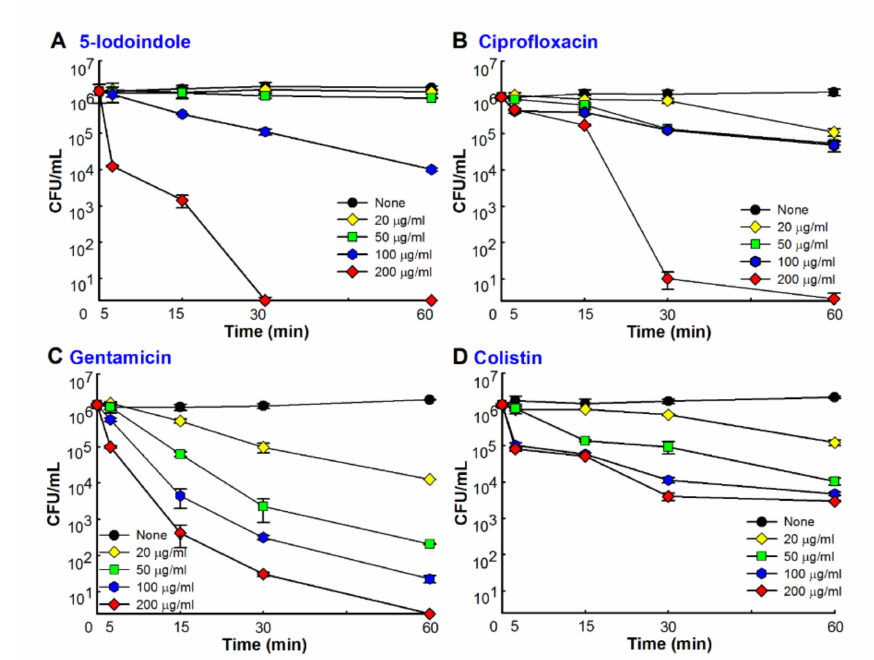
Figure 4. Rapid killing of A. baumannii by antibiotics and 5-iodoindole treated with 0, 20, 50, 100 or 200 µ g / mL of ( A ) 5-iodoindole; ( B ) or ciprofloxacin; ( C ) or gentamycin; ( D ) or colistin. After incubation with antibiotics, cultures were plated, and colony forming units (CFUs) were enumerated. Error bars represent standard